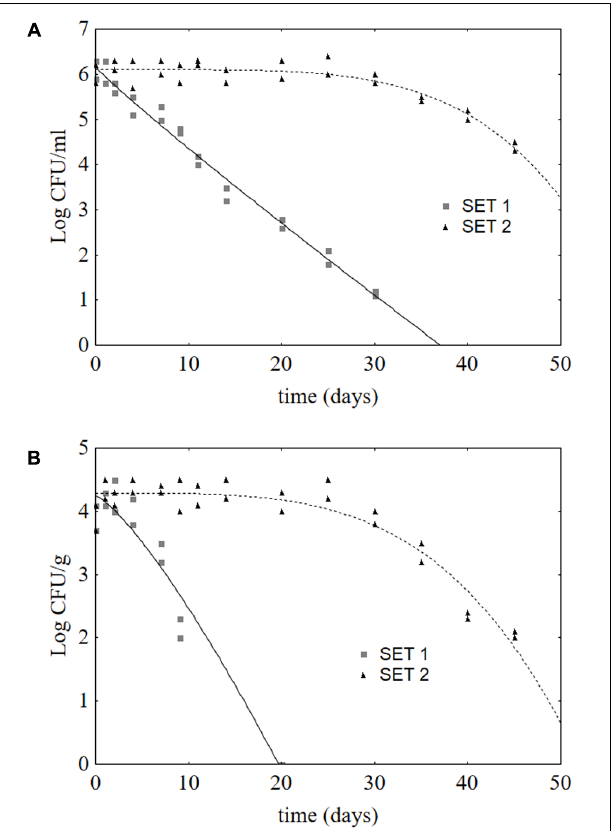
FIGURE 6 | Death kinetics of L. monocytogenes in brines (A) and on olive surfaces (B) . The lines represent the best fitting through the Weibull equation: SET1 (bio-preserved) and SET2